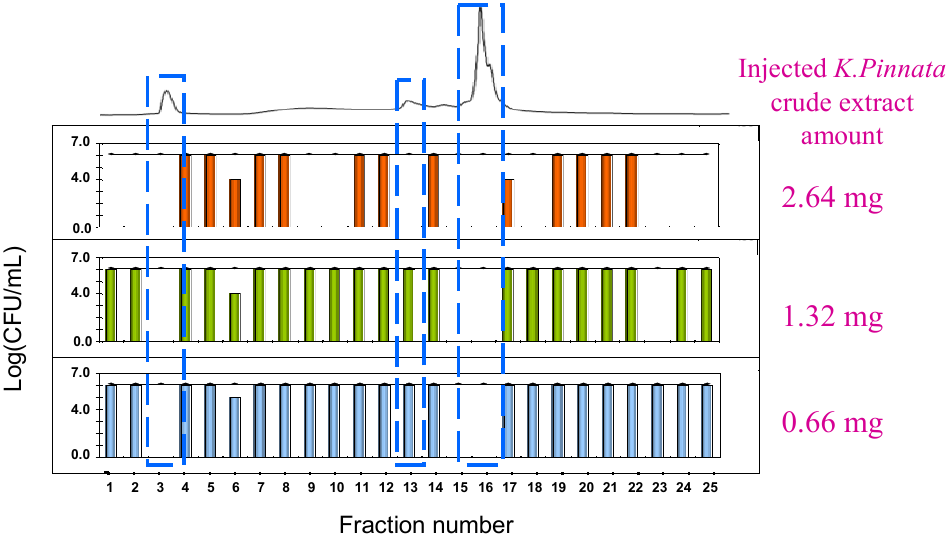
Figure 2. Correlation between chromatographic profile of Kalanchoe pinnata leaf methanolic extract and antibacterial activity against Escherichia coli